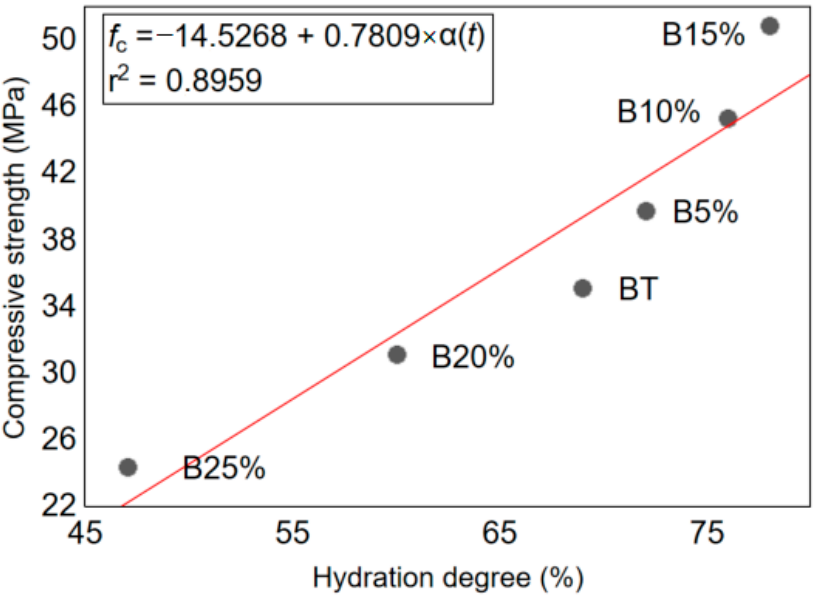
Figure 5. Correlation between the hydration degree and the compressive strength of the concrete with waste glass powder admixture.